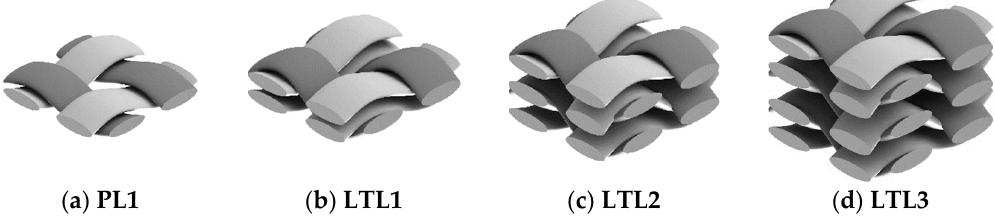
Figure 8. Overview of the basic fabric weave and their structure: ( a ) plain-woven fabric; ( b – d ) layer-to-layer weaves. Table 3. Selection of possible partitioning options in the structure of the fabric samples with 2 to 10 yarn layers. The examined variants are marked with x. The numbering is consecutive for the identification of the respective sample.